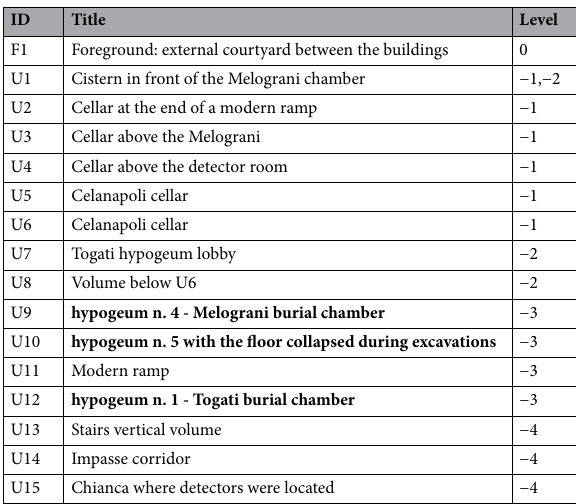
Table 1. List of all accessible underground structures. Levels are defined as follows: 0 for the street level on 4 m, −2 at the depth of 5 6 m, −3 for the Hellenistic necropolis the surface, −1 for cellars at the depth of 2 ÷ ÷ 10 m; −4 for the lowest structures at the depth of 14 18 m. Bold text emphasizes the at the depth of 7 ÷ ÷ structures belonging to the Hellenistic historical